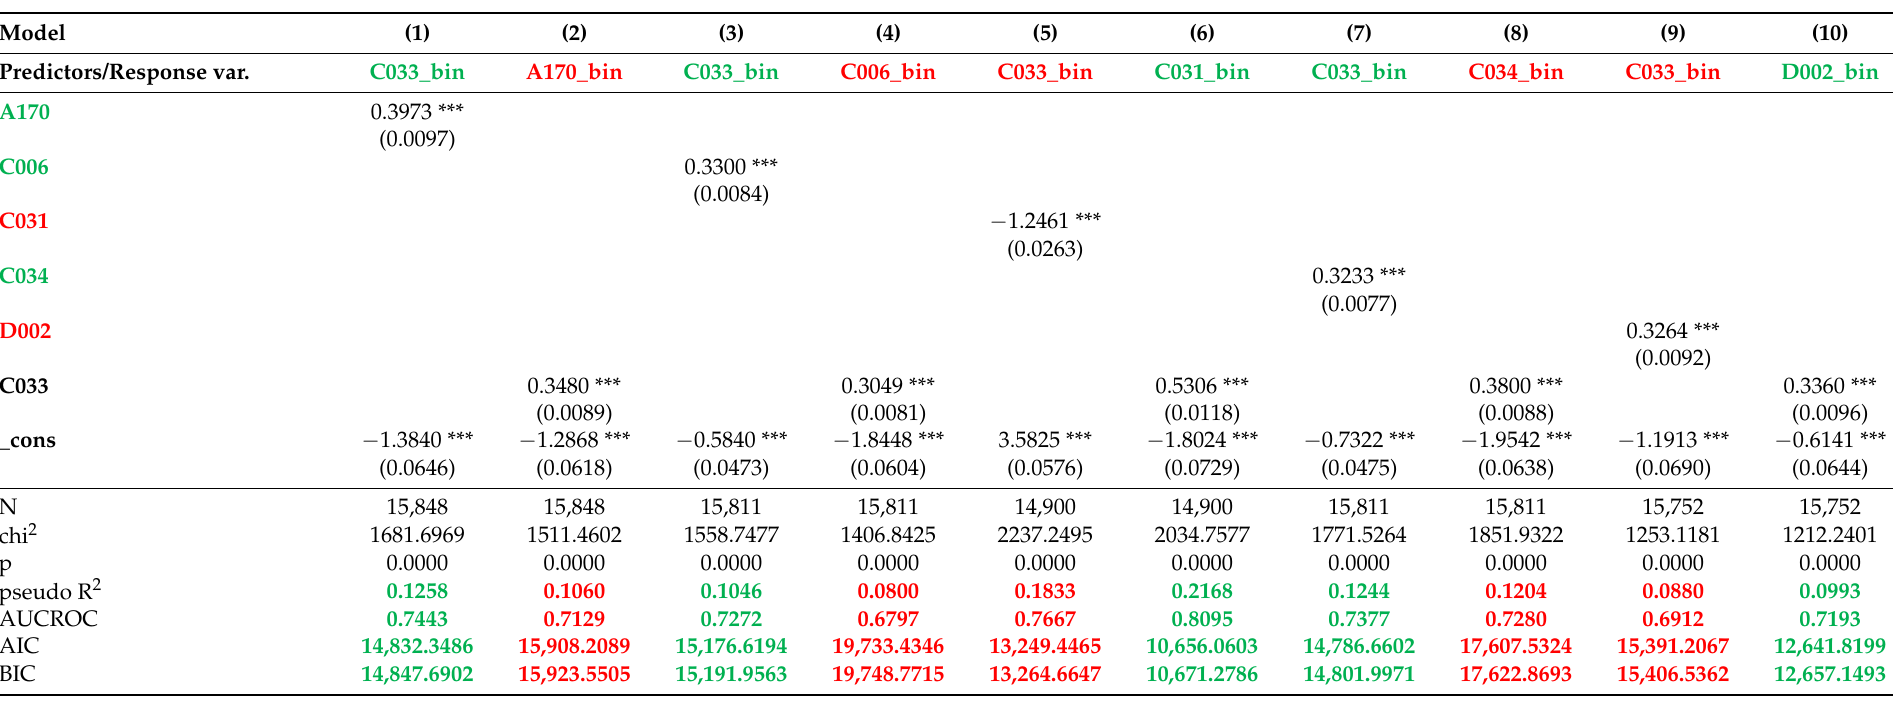
Table A3. Reverse causality checks using binary logistic regressions for job satisfaction and each potential predictor from those five resulting after using PCDM, LASSO, and